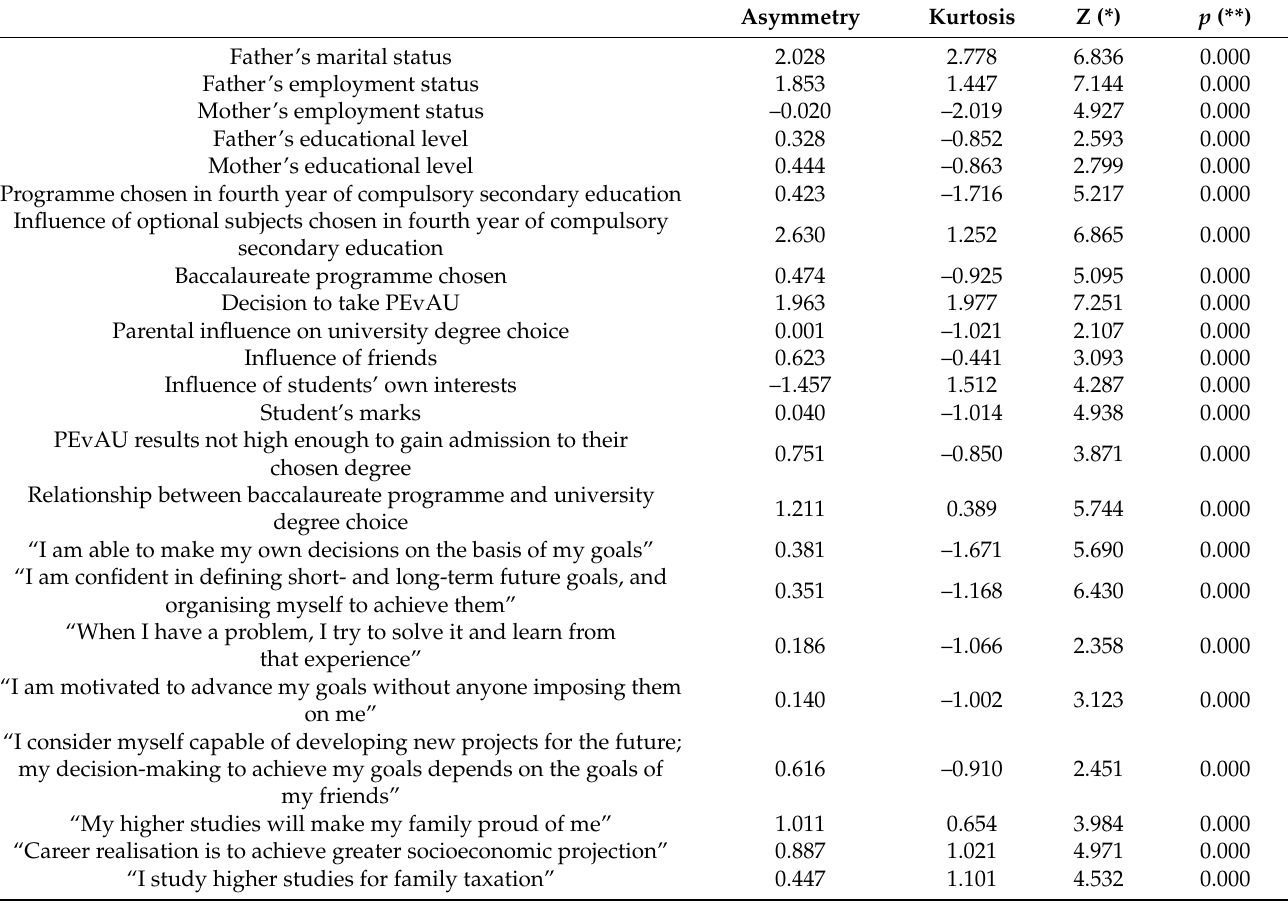
Table 2. Asymmetry, kurtosis, and Kolmogorov–Smirnov Z for EGPUQ. Note: PEvAU, university entrance